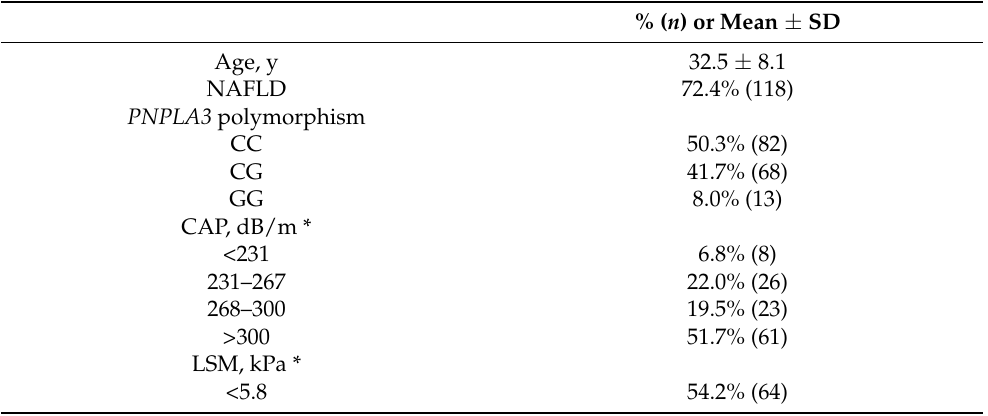
Table 1. Demographic, clinical and biochemical characteristics of the population studied ( n =